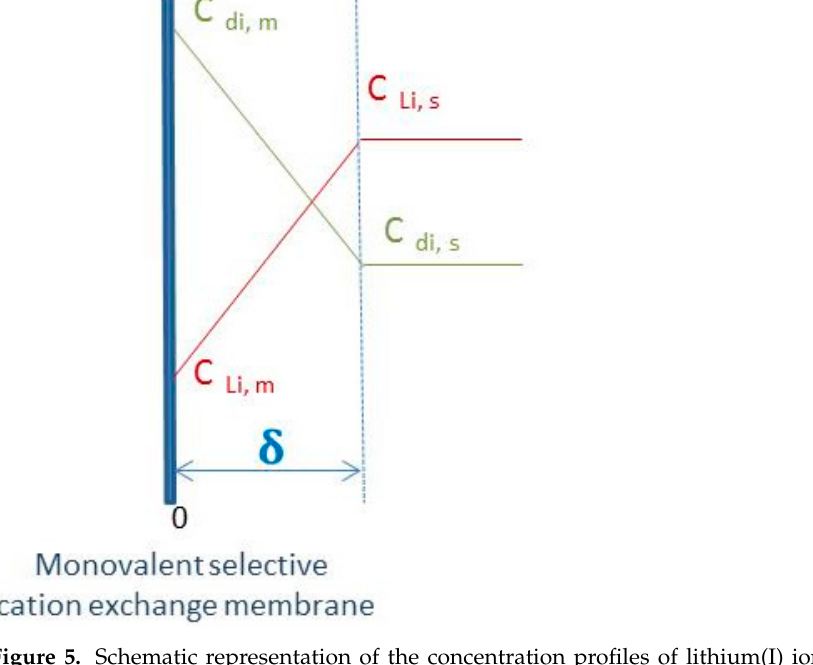
: lithium con ‐ Li,s : divalent cation div,s